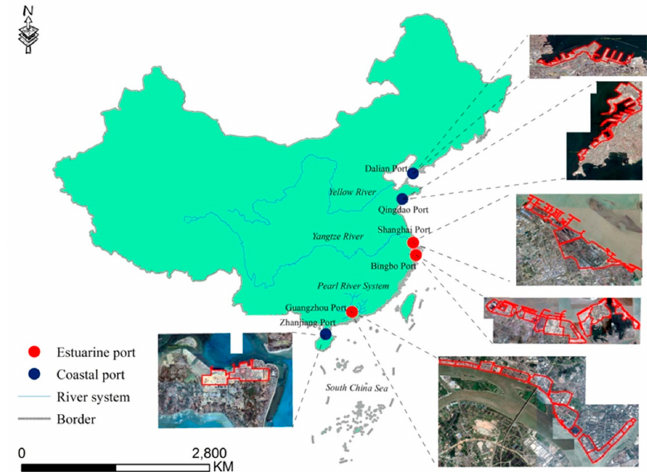
Figure 1. Location of study area (source: drawn by author).